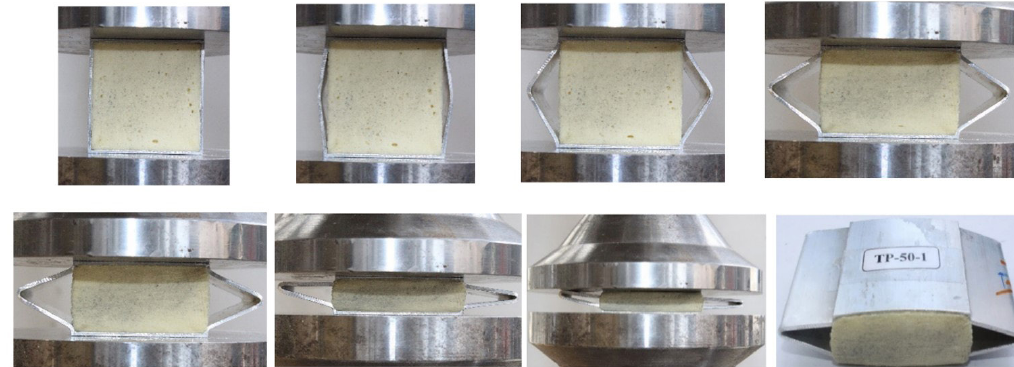
Figure 9. Stages of failure mode of a tube filled with polyurethane foam laterally crushed.